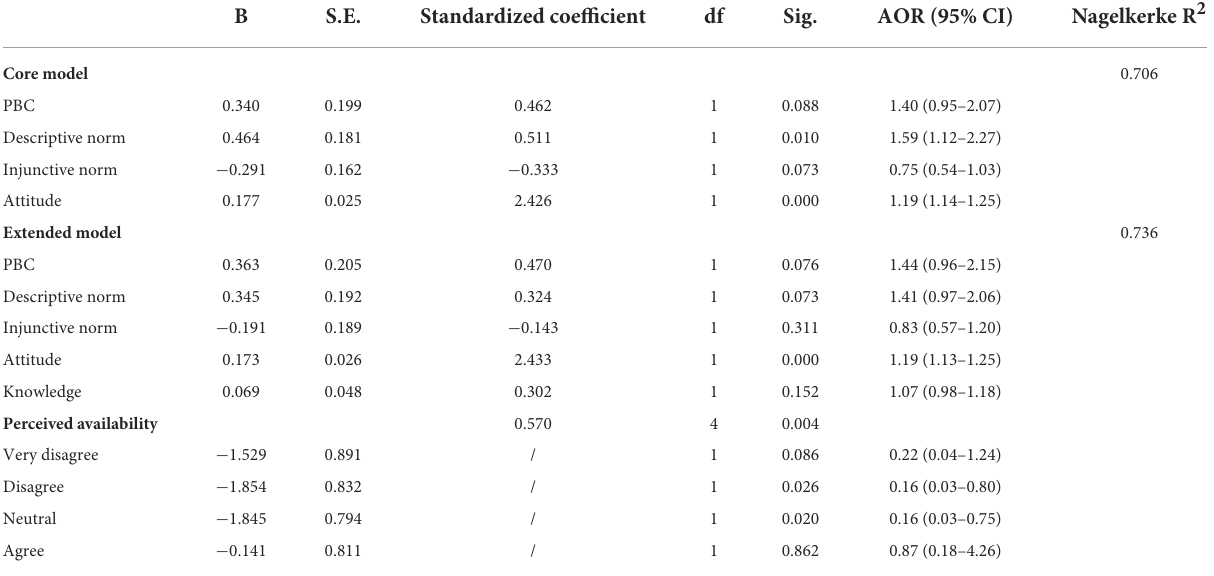
TABLE 4 Expanded theory of planned behavior model for cannabis use intention.